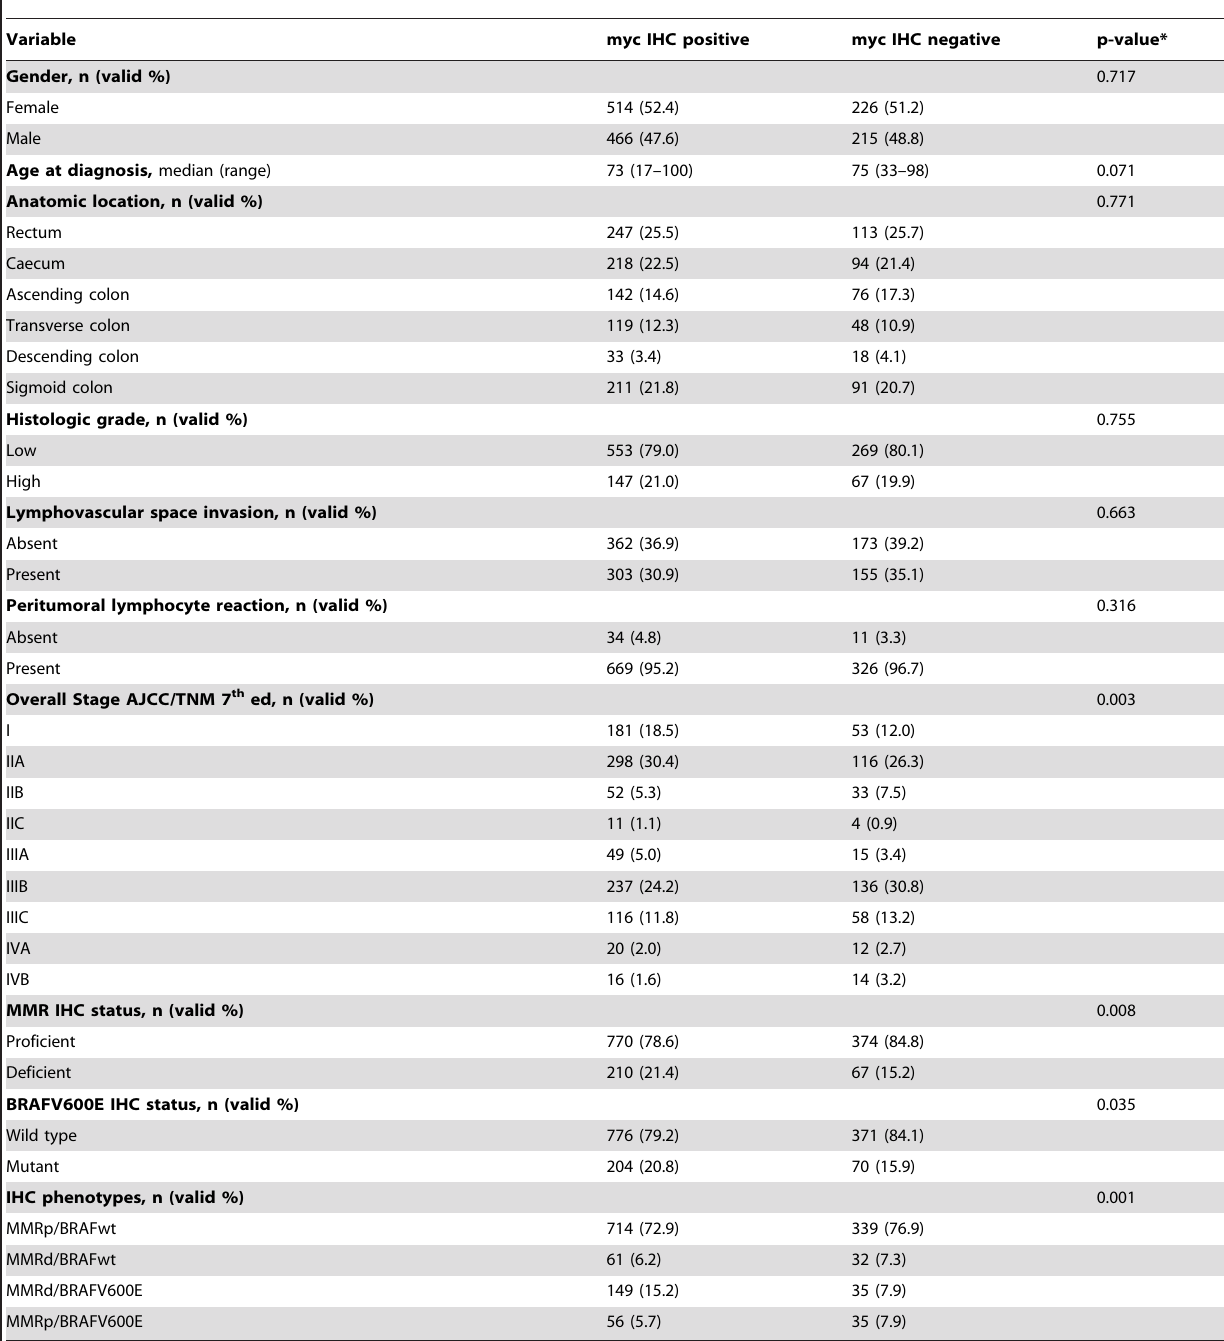
Table 1. Clinical and pathological characteristics of 1421 consecutive CRC patients